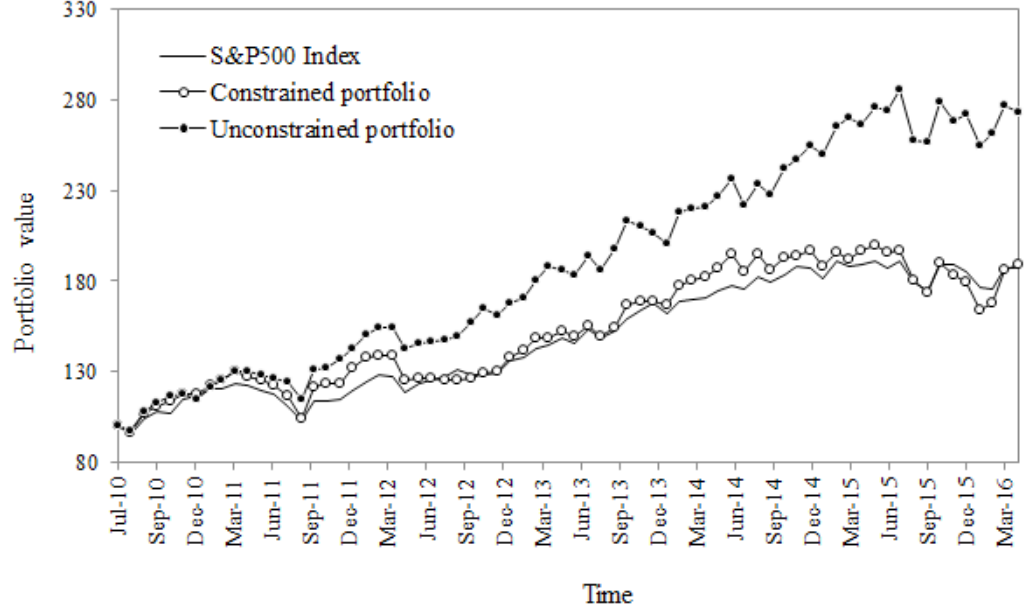
Figure 1. Cumulative monthly portfolio values, obtained by the constrained EIT portfolio ω  and